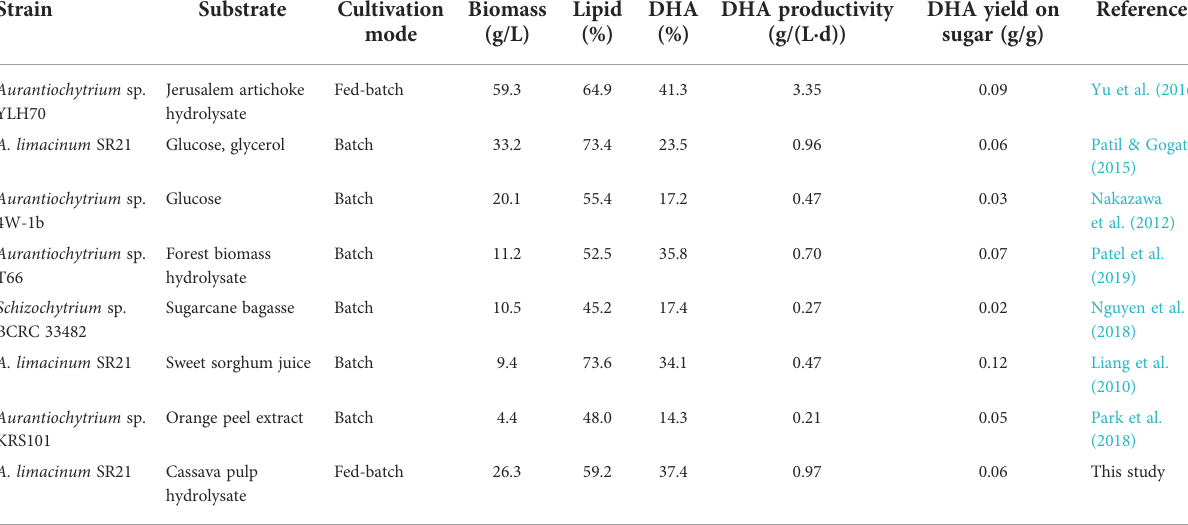
TABLE 5 Lipid and DHA productions by Aurantiochytrium spp. ( Schizochytrium spp.) growing on various substrates. Strain Substrate